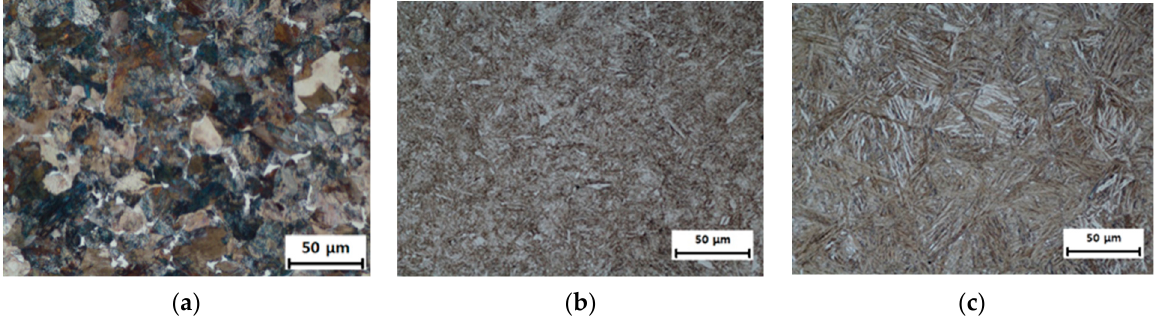
Figure 3. Examples of optical microscopy (OM) photographs of three specimens. ( a ) AR (the specimen before heat treatment), ( b ) QT, and ( c ) AT.